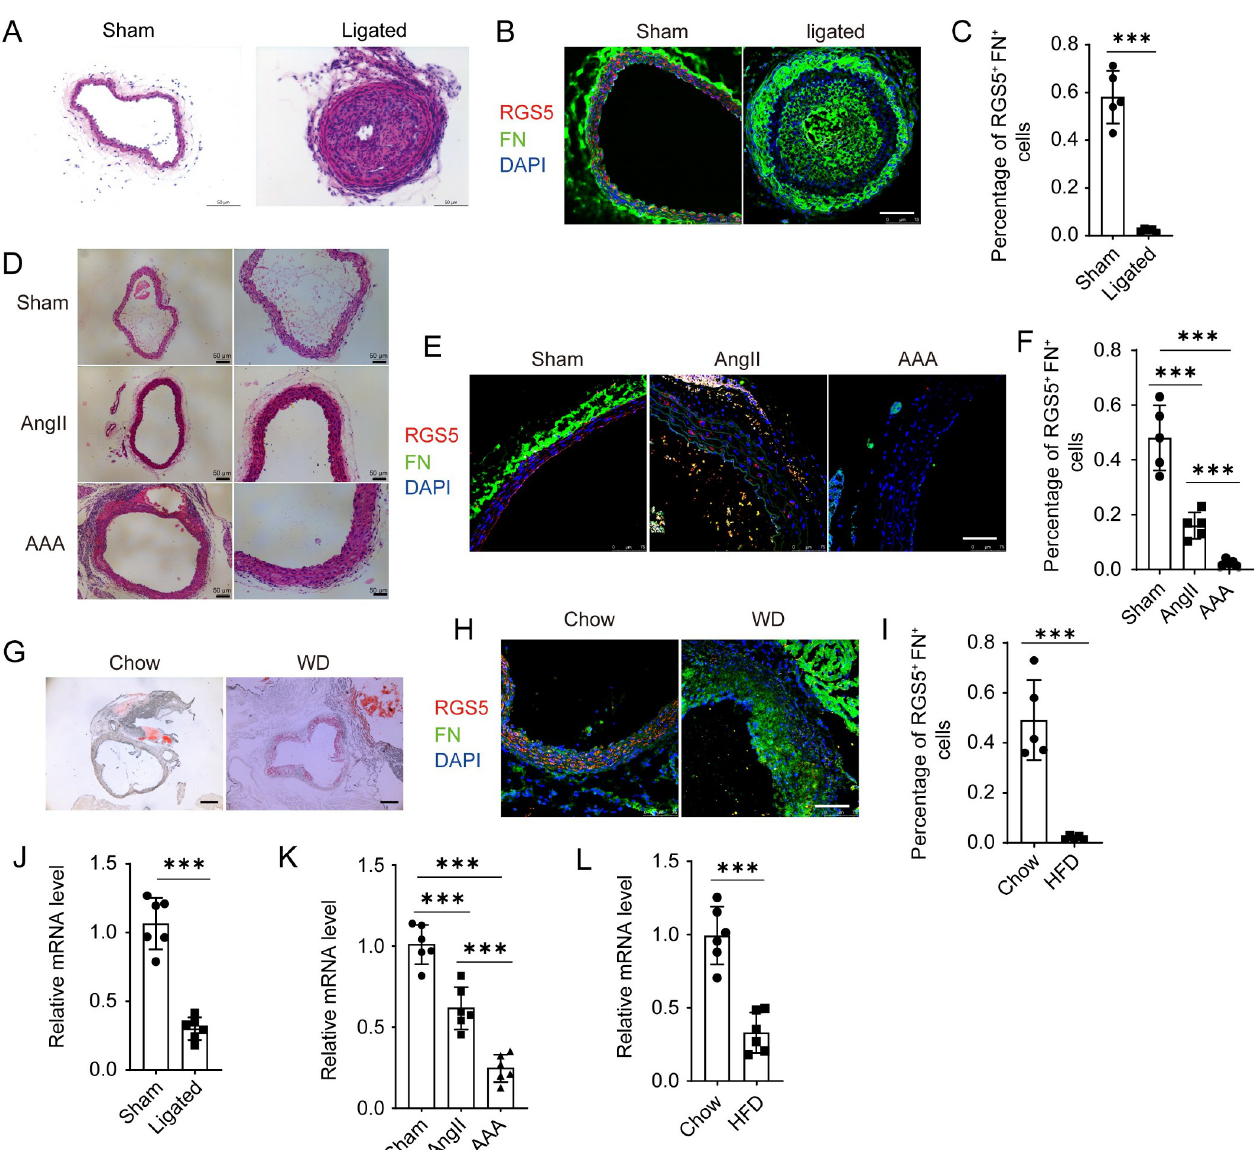
Fig 5. The role of RGS5 high VSMC subpopulation during vascular remodeling. (A) Representative HE staining images of neointima. Scale bar = 50 μ m. (B) Representative immunofluorescence microscopy images for RGS5 and FN in neointima. Scale bar = 75 μ m. (C) The percentage of RGS5 high and FN + VSMCs in neointima. Individual replicates and their mean are indicated and error bars show s.e.m, n = 6. ��� P < 0.0001. (D) Representative HE staining images of AngII treated abdominal aorta of mice. Scale bar = 50 μ m. (E) Representative immunofluorescence microscopy images for RGS5 and FN in AngII treated abdominal aorta. Scale bar = 75 μ m. (F) The percentage of RGS5 high and FN + VSMCs in AngII treated abdominal aorta. Individual replicates and their mean are indicated and error bars show s.e.m, n = 5. ��� P < 0.0001. (G) Representative images of Oil Red O staining for aortic roots sections. Scale bar = 50 μ m. (H) Representative immunofluorescence microscopy images for RGS5 and FN in atherosclerotic plaque of aortic roots sections. Scale bar = 75 μ m. (I) The percentage of RGS5 high and FN + VSMCs in atherosclerotic plaque. Individual replicates and their mean are indicated and error bars show s.e.m, n = 5. ��� P < 0.0001. (J-L) RT-qPCR analysis for the expression of RGS5 in ligated common carotid artery, AngII treated abdominal aorta or aorta with plaque. n = 6. ��� P <